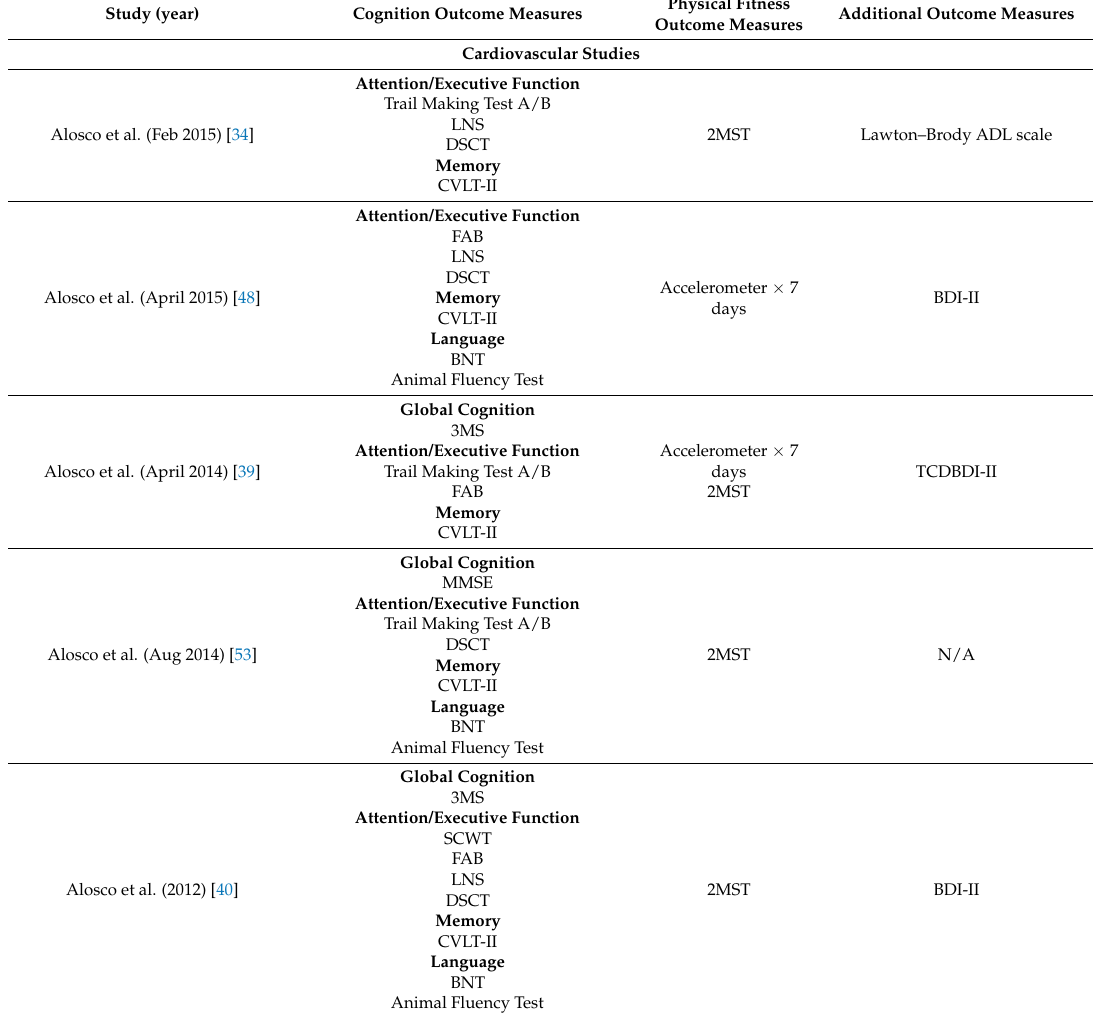
Table 1. Study Outcome